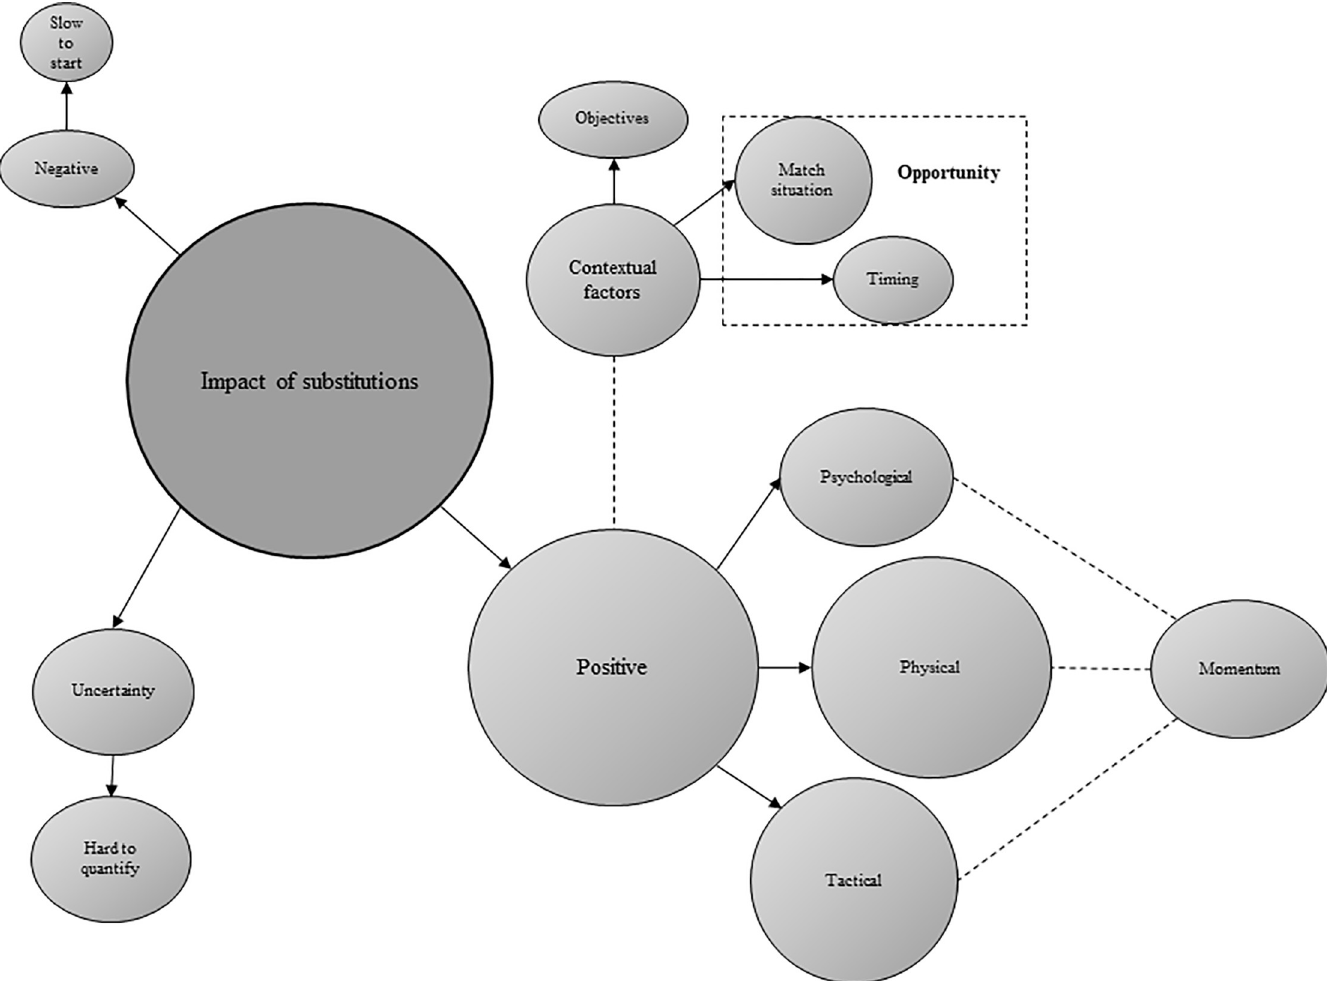
Fig 1. Thematic emergences depicting practitioner responses concerning the impact of substitutions (n = 33). Prevalence is indicated by size.